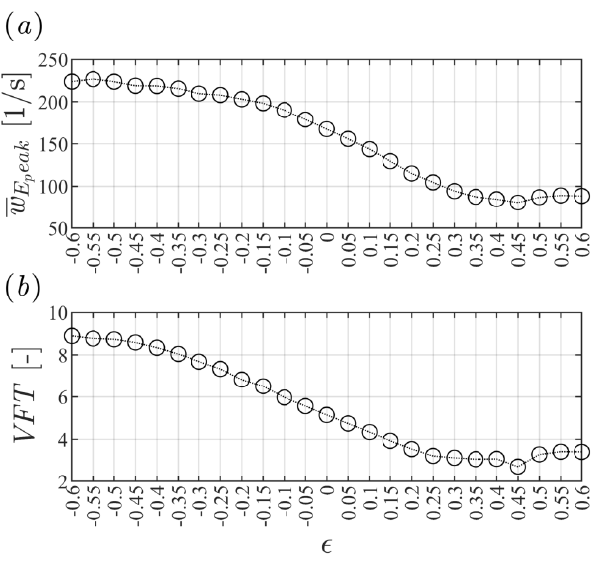
Figure 3. Graphical representation of ( a ) diastolic peak values of mean vorticity and ( b ) VFT values for different valve